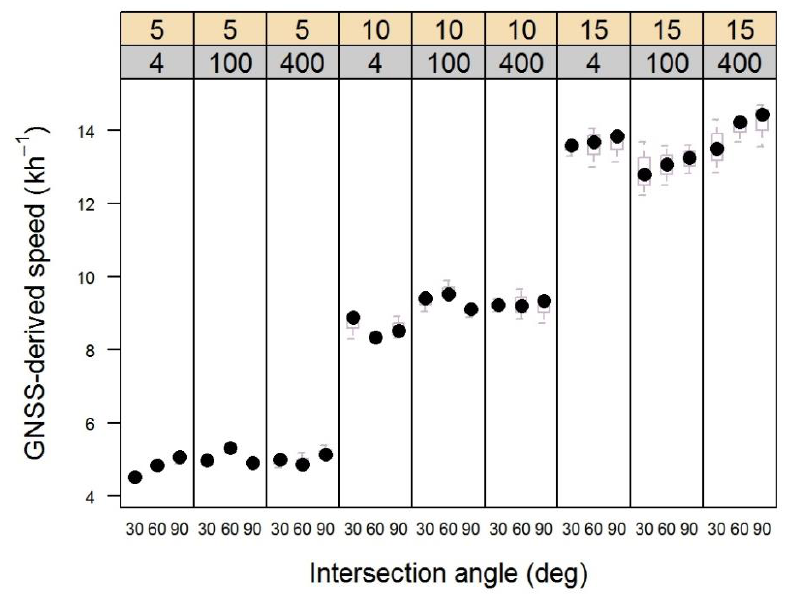
Figure 3. Box-and-whiskers plot showing the distribution of GNSS-based cart speeds for all trials in the experiment. Upper panel numbers are speed (5 kph, 10 kph, 15 kph). Sub-panel scale is receiver distance (4 m, 100 m, 400 m).